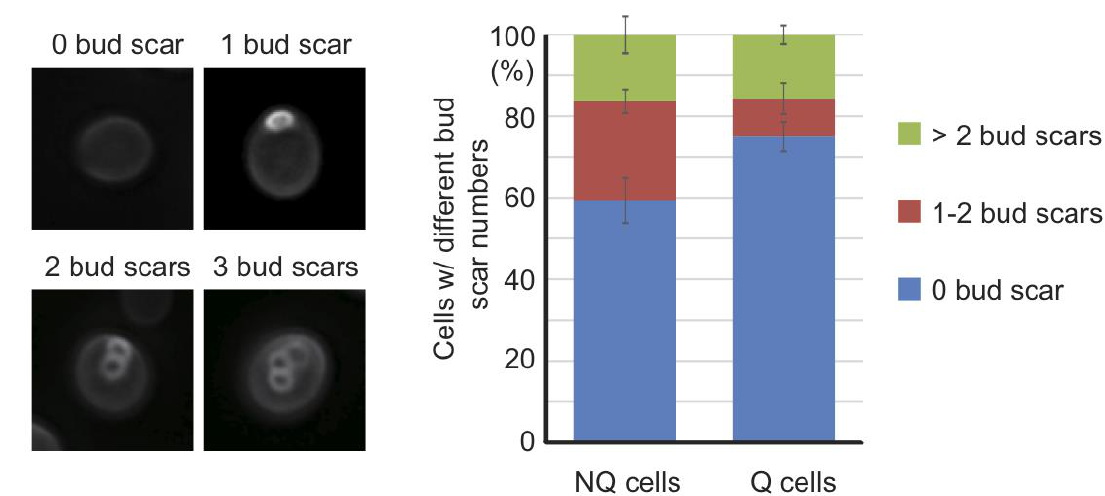
FIGURE 6: A large proportion of NQ cells have one or no bud scar. After the bud scars of Q and NQ cells were stained with calcofluor white, z-stack images were taken and analyzed manually. Three repeats were performed for each cell type and at least 100 cells were analyzed in each repeat. Error bars represent the standard error. The left panel shows typical images of cells with 0, 1, 2 and 3 bud